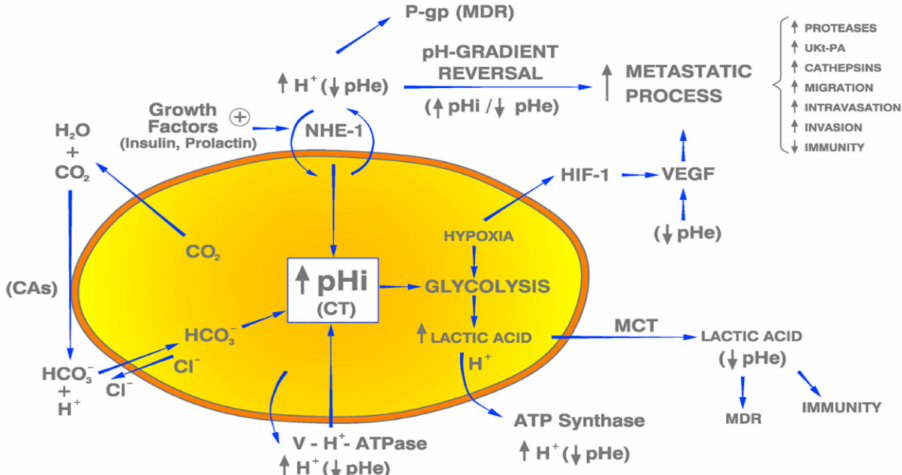
Figure 1. Proton transporters and proton pumps involved in the carcinogenicity of breast cancer and other malignant tumors. pHi: intracellular pH; CT: cell transformation; pHe: extracellular pH; PTs: proton transporters; PPs: Proton pumps; NHE-1: Na + / H + antiporter; H + : hydrogen ion; CAs: carbonic anhydrases; MCT: monocarboxylate transporters; P-gp: P-glycoprotein; V-H + -ATPase: Vacuolar ATPase; MDR: Multiple drug resistance. Blue arrows: Induction. Black arrows: Result. Yellow color: intracellular space of a tumor